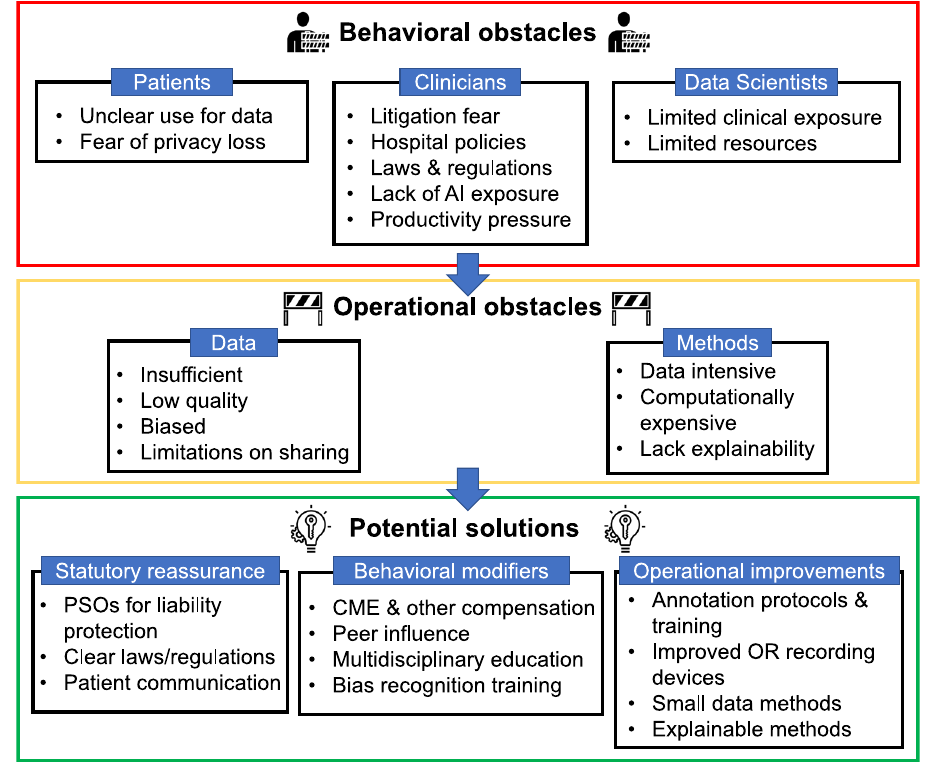
Fig. 3 Obstacles and possible solutions for CV in surgery. Behavior and technical/operational obstacles can limit the development and implementation of CV models in surgery. A combination of statutory, behavioral, and operational changes in the regulatory, clinical, and technical environments could result in improvements in the application of CV for surgery. AI arti fi cial intelligence, PSO patient safety organization, CME continuing medical education, OR operating